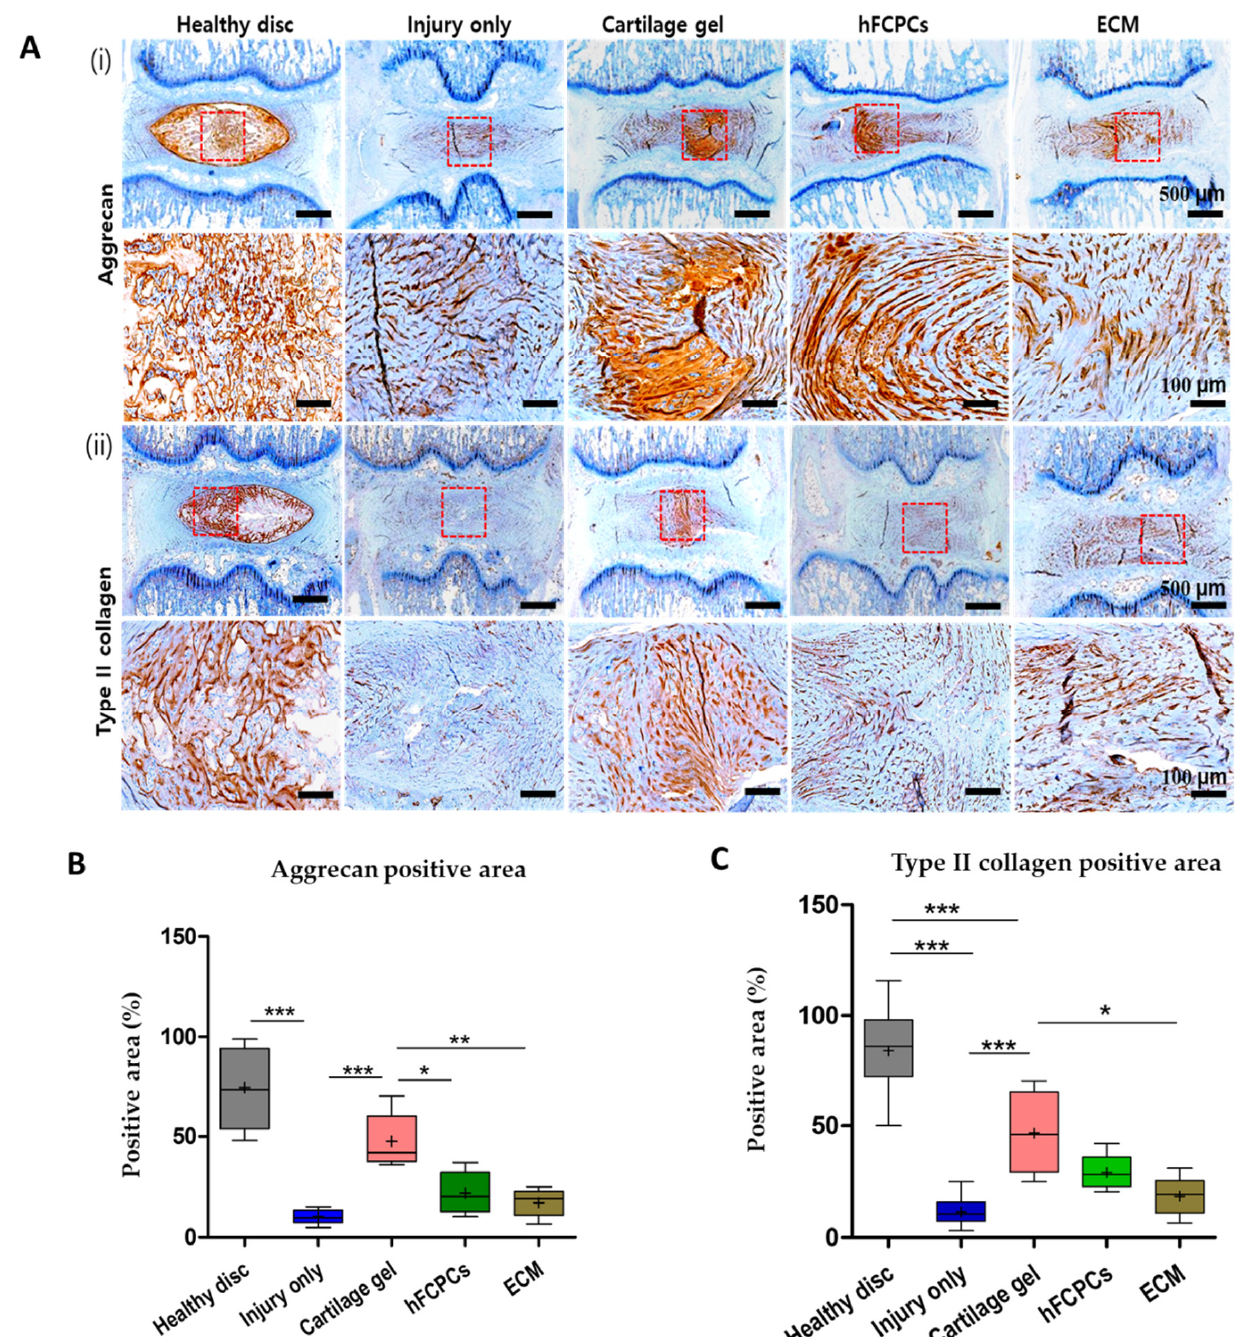
Figure 3. The cartilage gel preserved the matrix proteins in disc nucleus pulposus (NP) of a rat nucleotomy model. Immunohistochemical images of the indicated genes are presented for the healthy discs, injury-only discs, and the cartilage gel-injected, hFCPCs-injected, or ECM-injected discs at 6 weeks after surgery. ( A ) Immunohistochemistry of aggrecan (i) and type II collagen (ii). ( B ) Changes in the percentage of aggrecan-positive area in the disc NP spaces. The whole IVD images with merged signals are also presented at the bottom. ( C ) Changes in the percentage of type II collagen-positive area in the disc NP spaces. In ( B , C ), data are presented with box plots ( n = 6, * p < 0.05; ** p < 0.01, *** p < 0.001, significant difference by one-way ANOVA). hFCPCs, human fetal cartilage-derived progenitor cells; ECM, extracellular matrix.